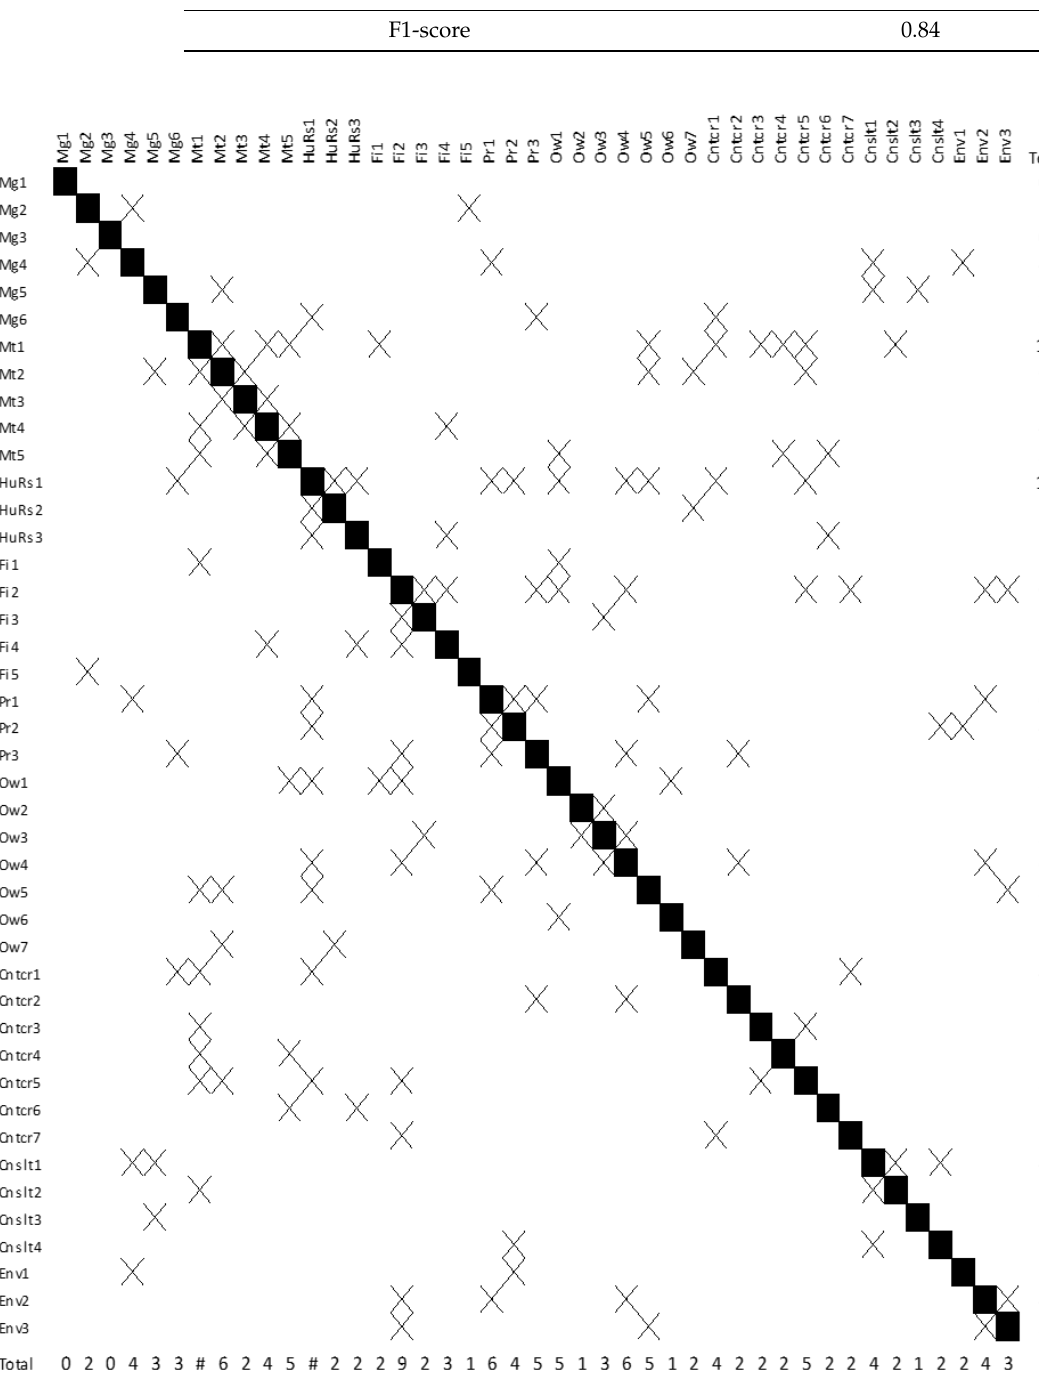
Figure 5. Relationships between risks.